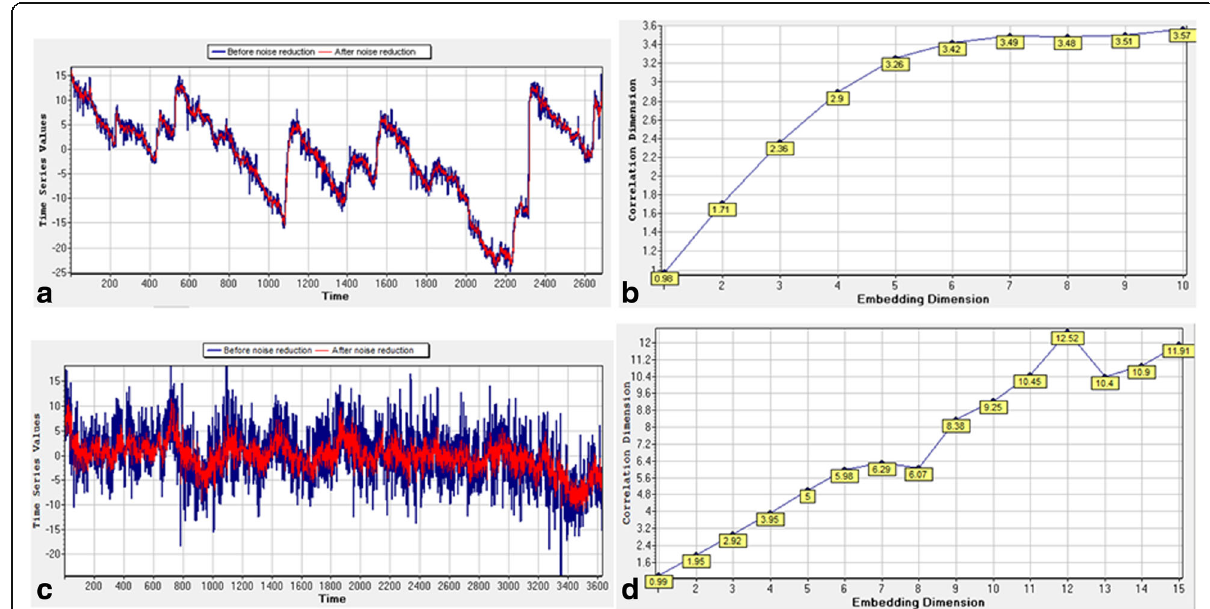
Fig. 15 Nonlinear noise reduction for CNST data sets. In left hand panels blue is original signal and red is the signal after noise reduction. a Noise reduction for CNST_e; 76% noise reduction. b Plot of correlation dimension against embeddding dimension for CNST_e after noise reduction. This should be compared to Fig. 13a. c Noise reduction for CNSTE_u; 80% noise reduction. d Plot of correlation dimension against embeddding dimension for CNST_u after noise reduction. This should be compared to Fig. 13c